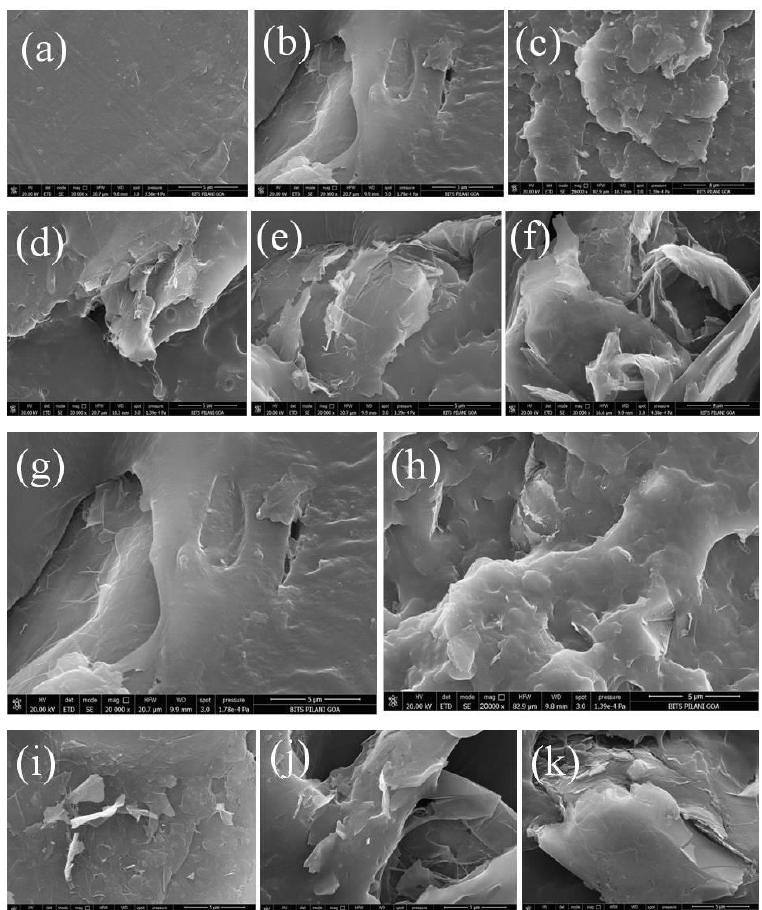
Figure 8. FESEM images of ( a ) neat PP, ( b – f ) PP-H25 and ( g – k ) PP-M25 nanocomposites with 1, 2, 3, 4 and 5 wt% GNPs respectively.